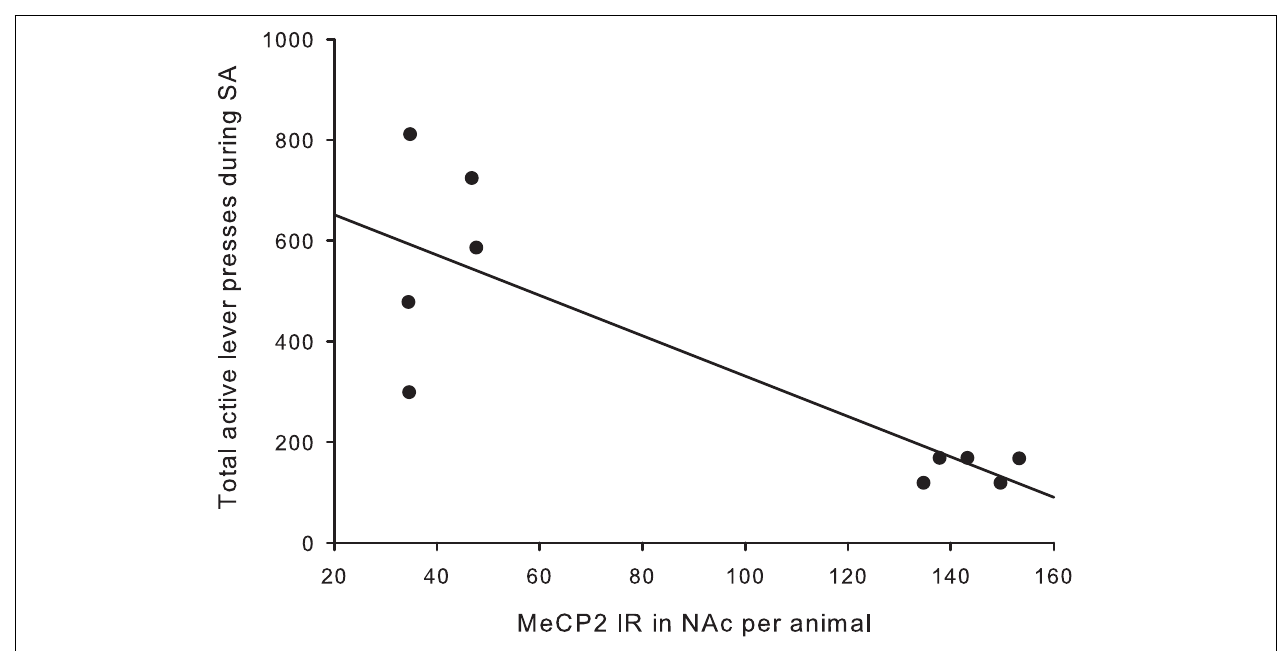
FIGURE 6 | Number of active lever presses negatively correlated with MeCP2 immunoreactivity in the NAc core ( r =− 0.836, p = 0.003) .